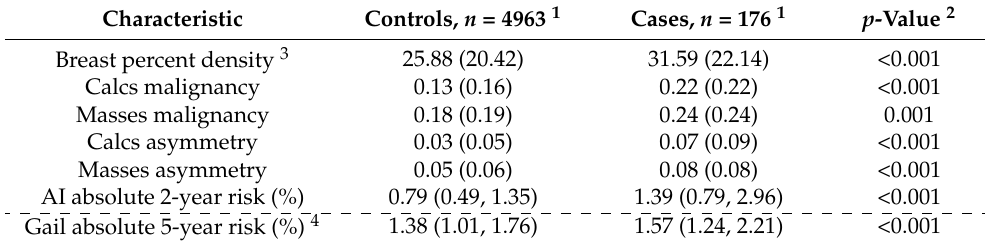
Table 2. AI and Gail risk scores in study dataset: Distributions by case–control status.